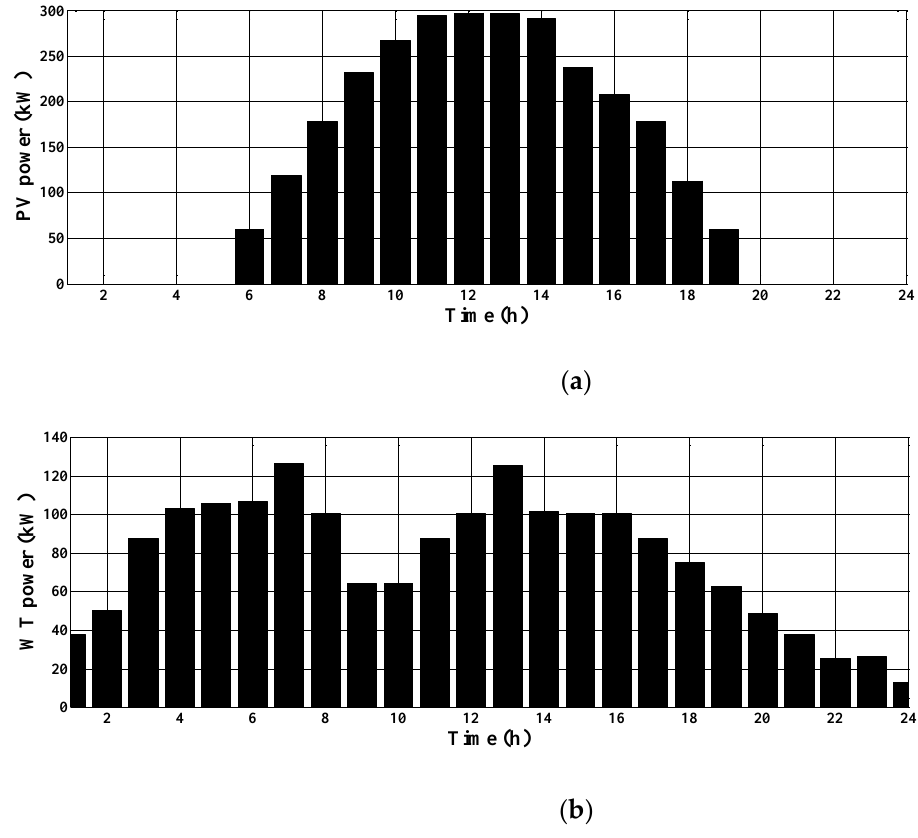
Figure 10. The hourly output power of RERs ( a ) photovoltaic (PV) unit, ( b ) wind turbine (WT).